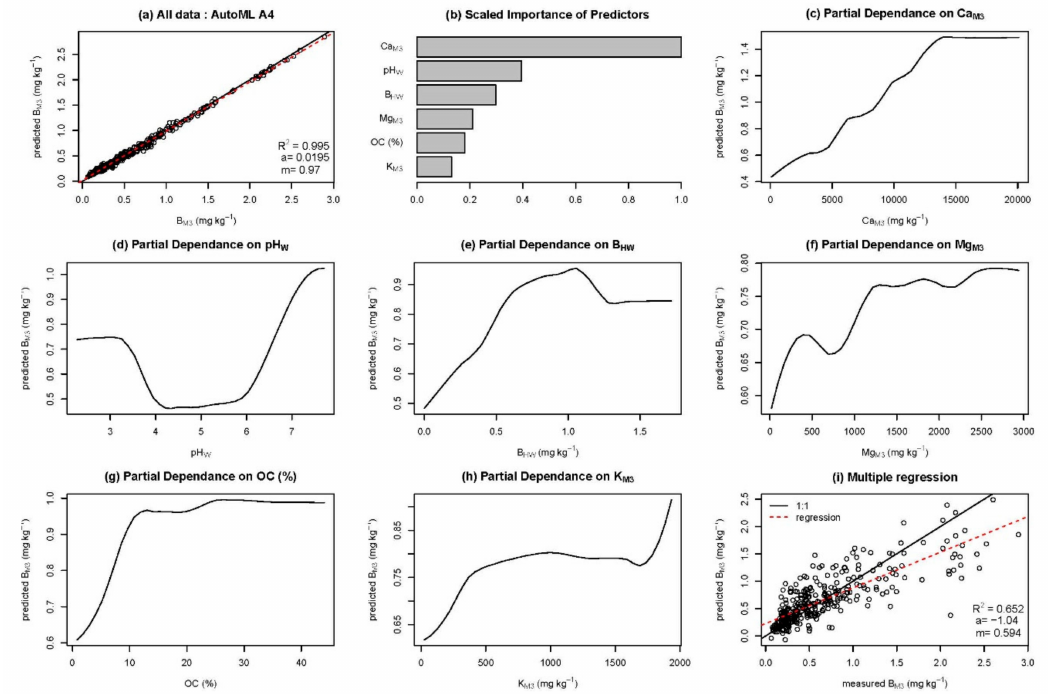
Figure 3. Boron Mehlich-3 (B M3 ) prediction and statistical analysis for algorithm AutoML A4 ( a – h ) and for multiple regression (i). ( a ) Correlation between measured and predicted B M3 ; ( b ) scaled importance of predictors (Ca M3 , pH W , Mg M3 , K M3 , B HW, OC); ( c – h ) partial dependence on Ca M3 , pH W Mg M3 , K M3 , B HW, OC, respectively; ( i ) correlation between measured and predicted B M3 by multiple